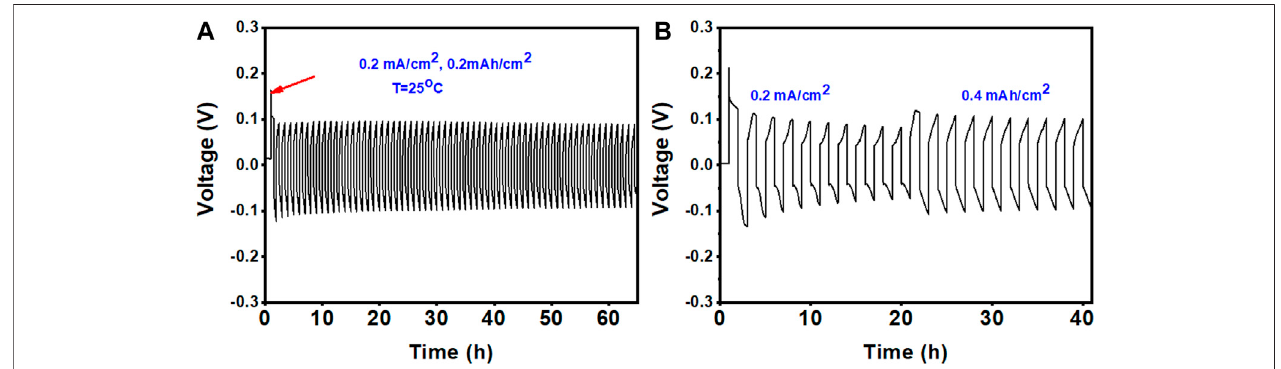
FIGURE 6| Stripping/plating performance ofthe Zn metal anode in the ZE electrolyte at different current densities: (A) 0.2 mAh cm − 2 and (B) fi rst fi ve cycles at 0.2 and 0.4 mAh cm − 2 .